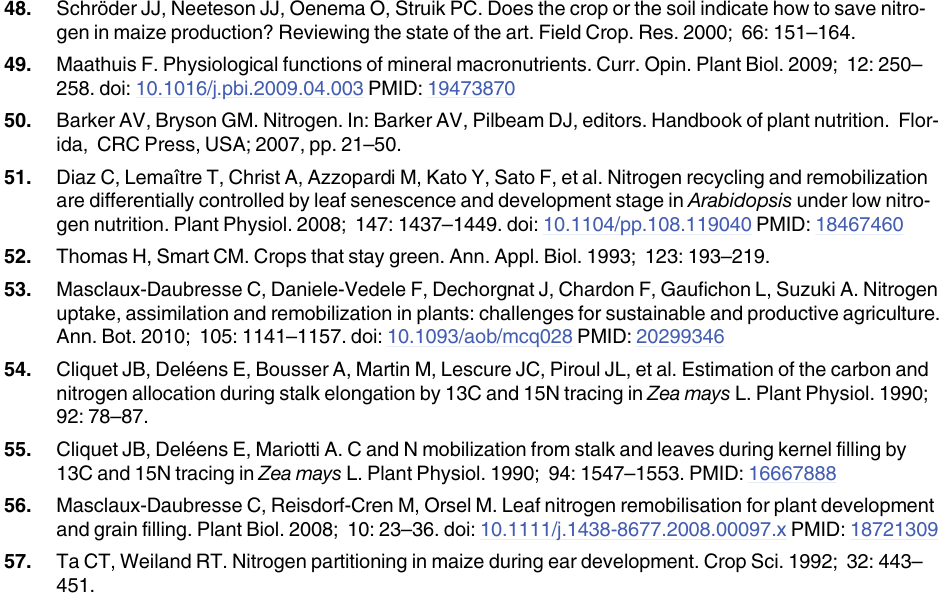
PLOS ONE | DOI:10.1371/journal.pone.0152478 March 24,